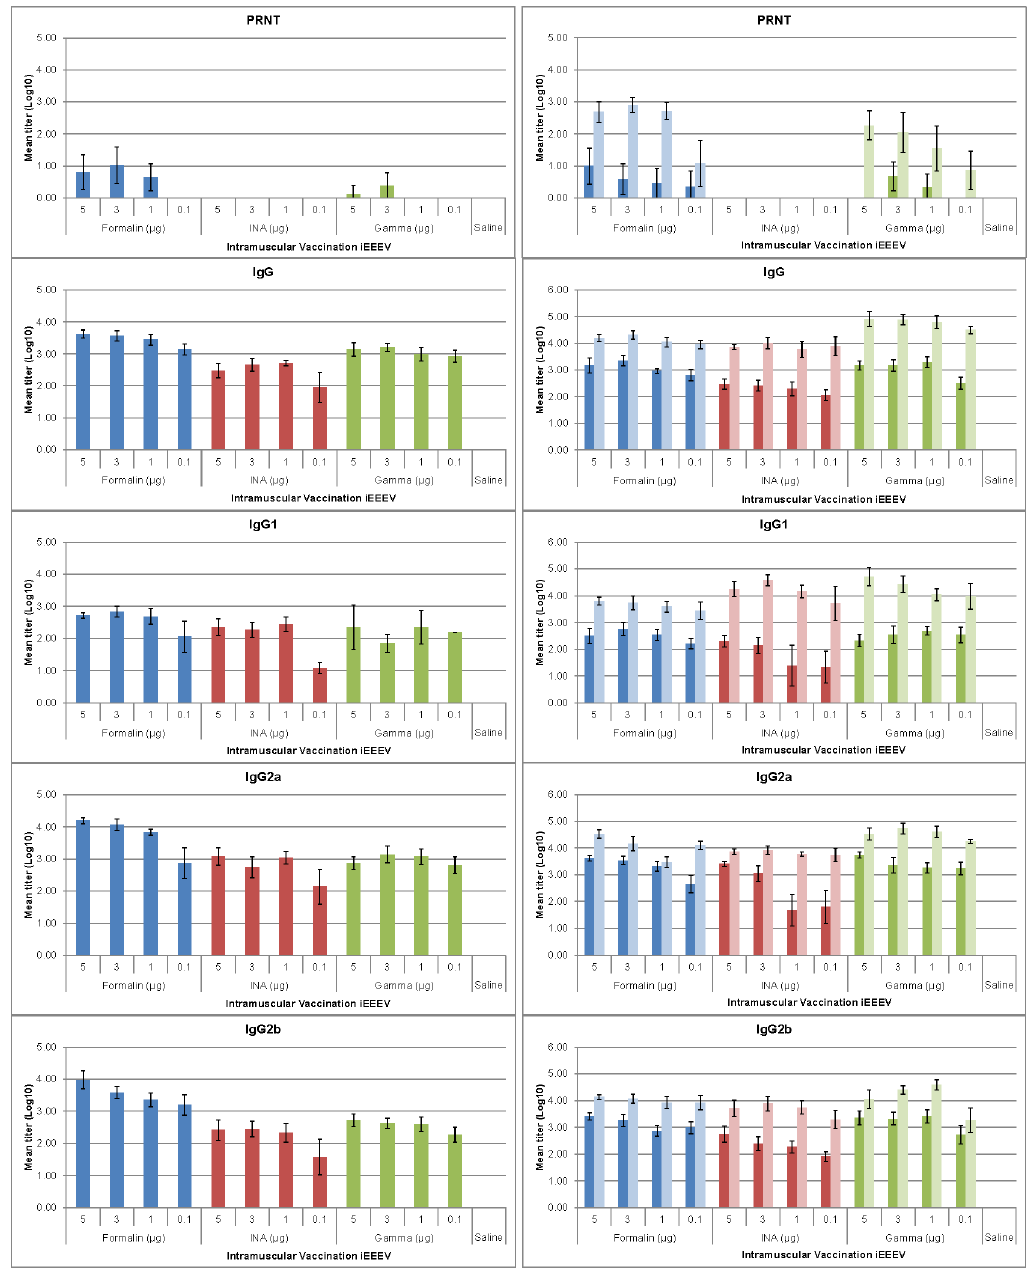
Figure 5. Serum antibody responses in mice vaccinated intramuscularly with iEEEV vaccine candidates. Groups of BALB/c mice (n=10) were vaccinated once (graphs on left) or twice (graphs on right) with one of three iEEEV vaccine candidates (formalin-inactivated, INA-inactivated, or gamma irradiated) at doses ranging from 5–0.1 m g by the IM route. Serum was collected 21 d after each vaccination. Neutralizing antibody responses were determined by PRNT and serum antibody levels were determined by ELISA. In all graphs, dark bars represent the mean group titer 21 d after the first vaccination (n=10); light bars represent the mean group titer 21 d after the second vaccination (n=10). Standard error bars represent 2 times the SE of the mean